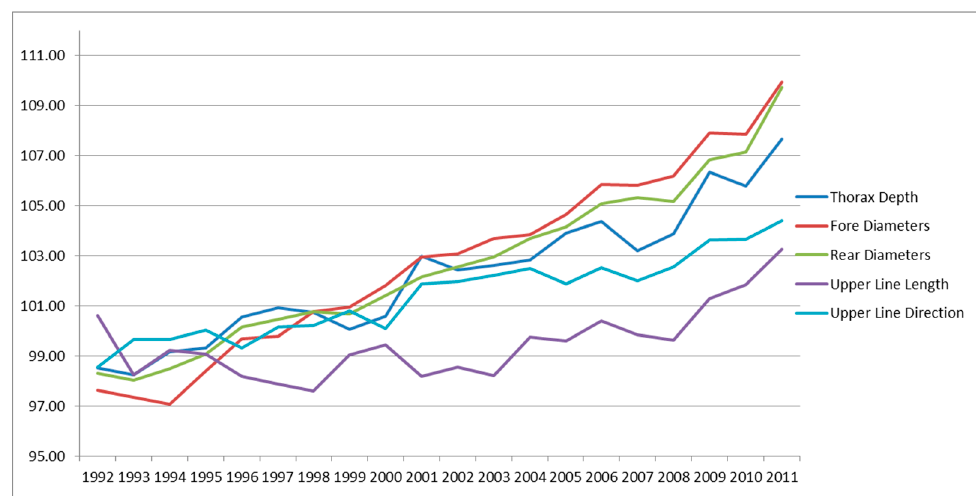
Figure 2. Genetic trends for linear type traits of trunk.